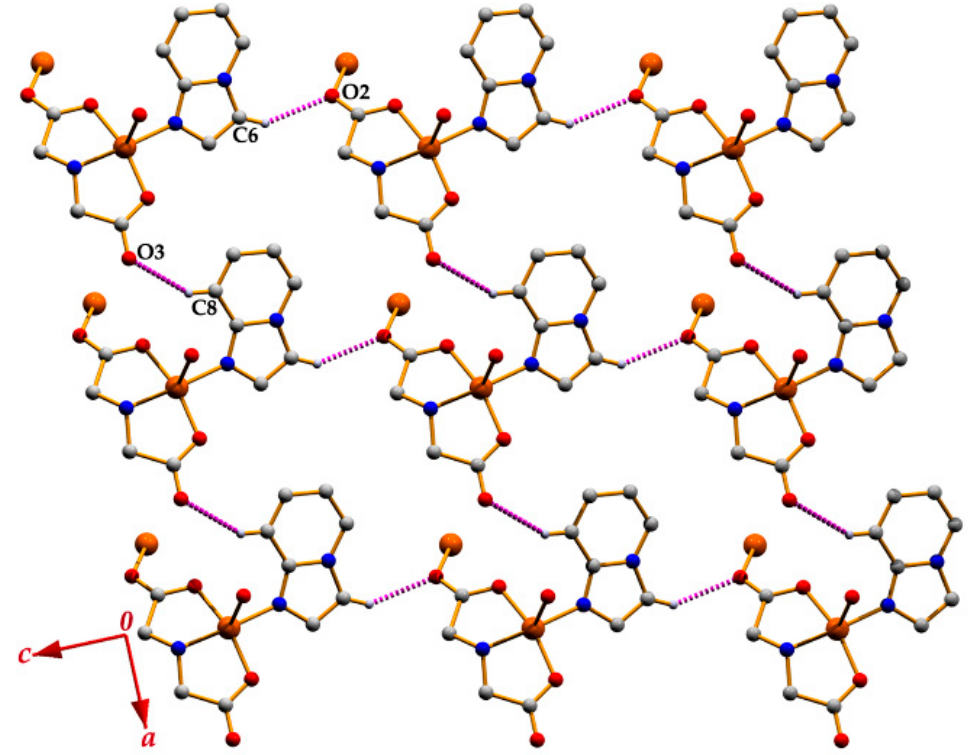
Figure 3. Perspective view of the supramolecular network generated through hydrogen bonds.